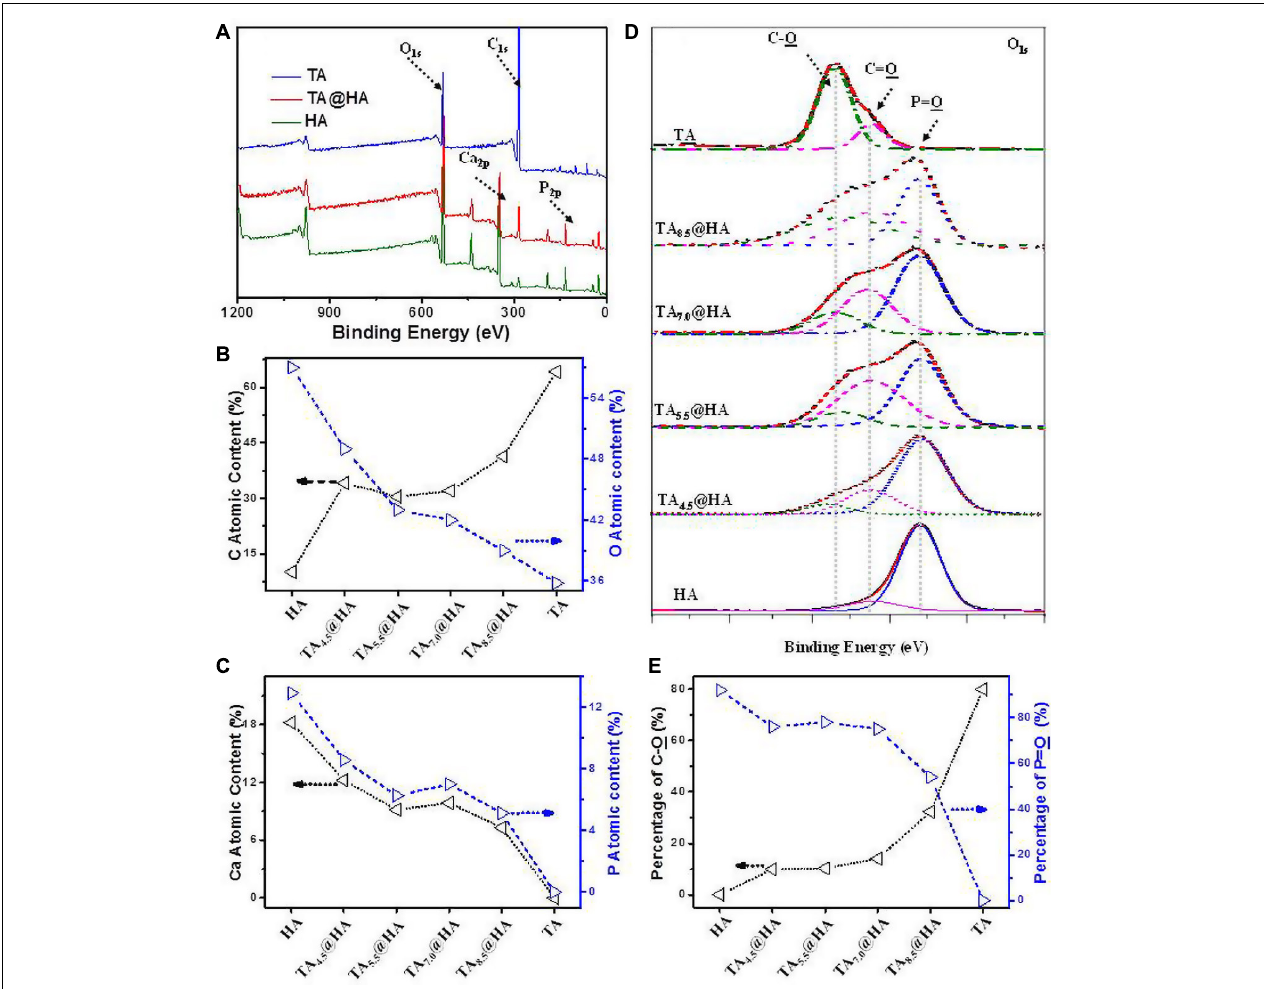
FIGURE 1 | (A) X-ray photoelectron spectrometer (XPS) spectra of tannic acid (TA), TA - 8 . 5 @HA, and hydroxyapatite (HA). (B) Carbon (C) and oxygen (O) contents and (C) Calcium (Ca) and phosphorus (P) contents in TA, TA - pH @HA, and HA. (D) Peak fitting in O 1s of XPS spectra of TA, TA - pH @HA, and HA. (E) C-O and P = O contents in TA, TA - pH @HA, and HA relative to the total O calculated from (D) . The line in all figures was used for eye